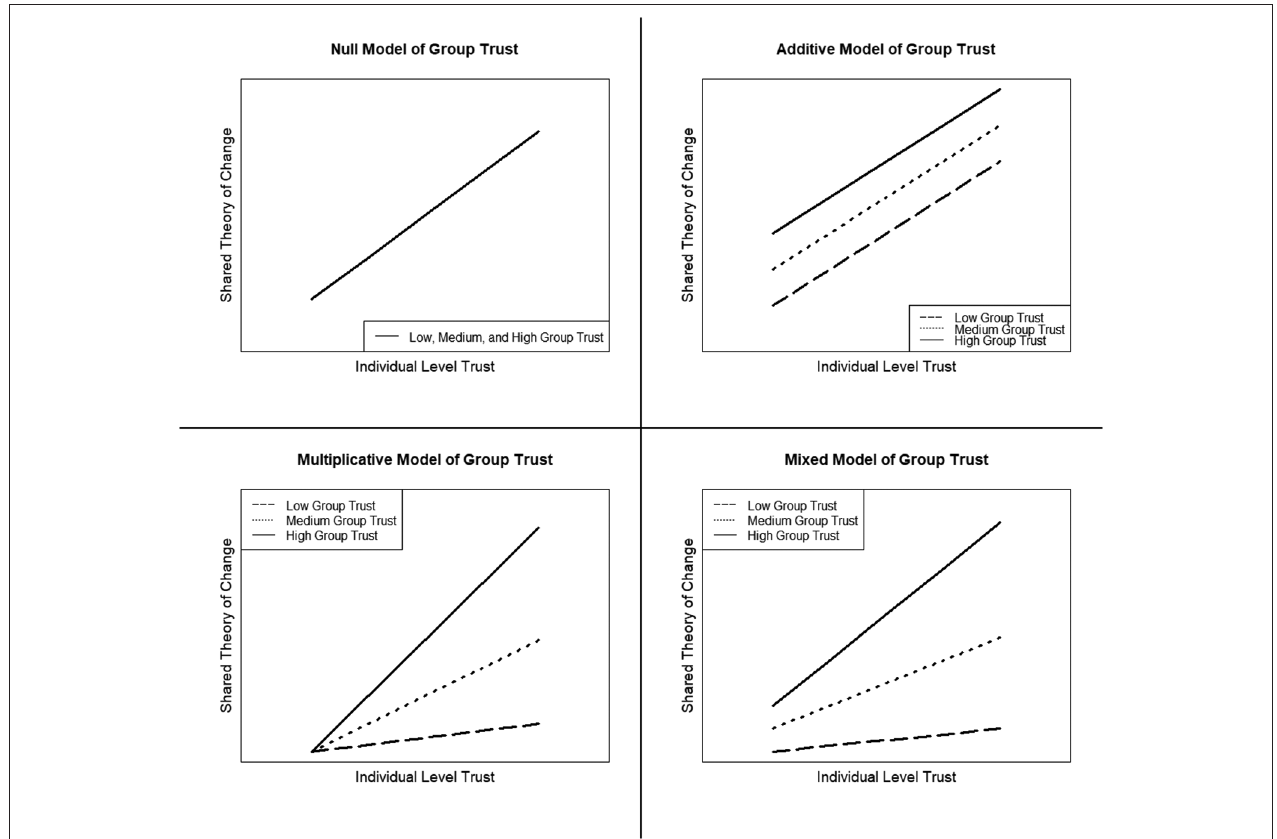
FIGURE 2 | Possible relationships between group trust, individual trust, and the development of a shared theory of